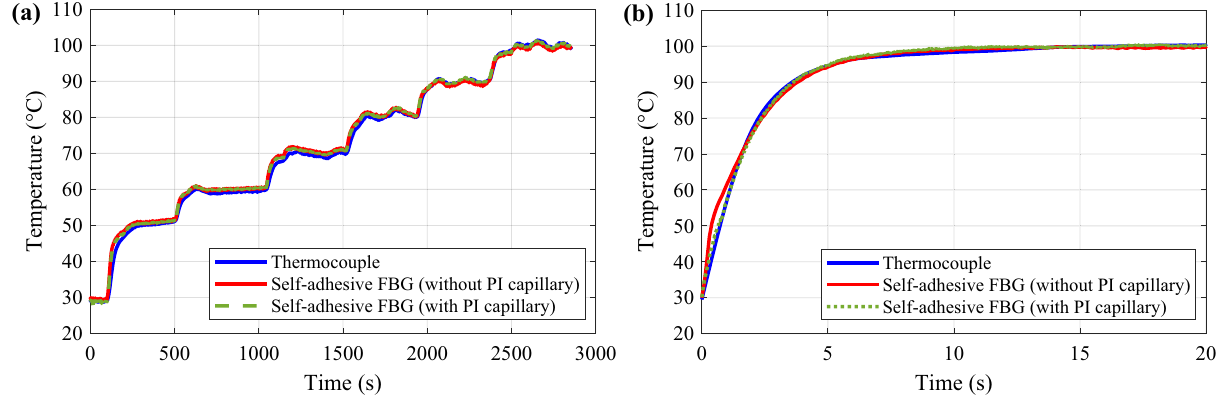
Figure 8. Comparison between the temperature measured by the self-adhesive FBG sensors with and without PI capillary and a reference thermocouple. Experiment performed applying ( a ) a stepwise temperature increase, and ( b ) a single 70 °C temperature step.